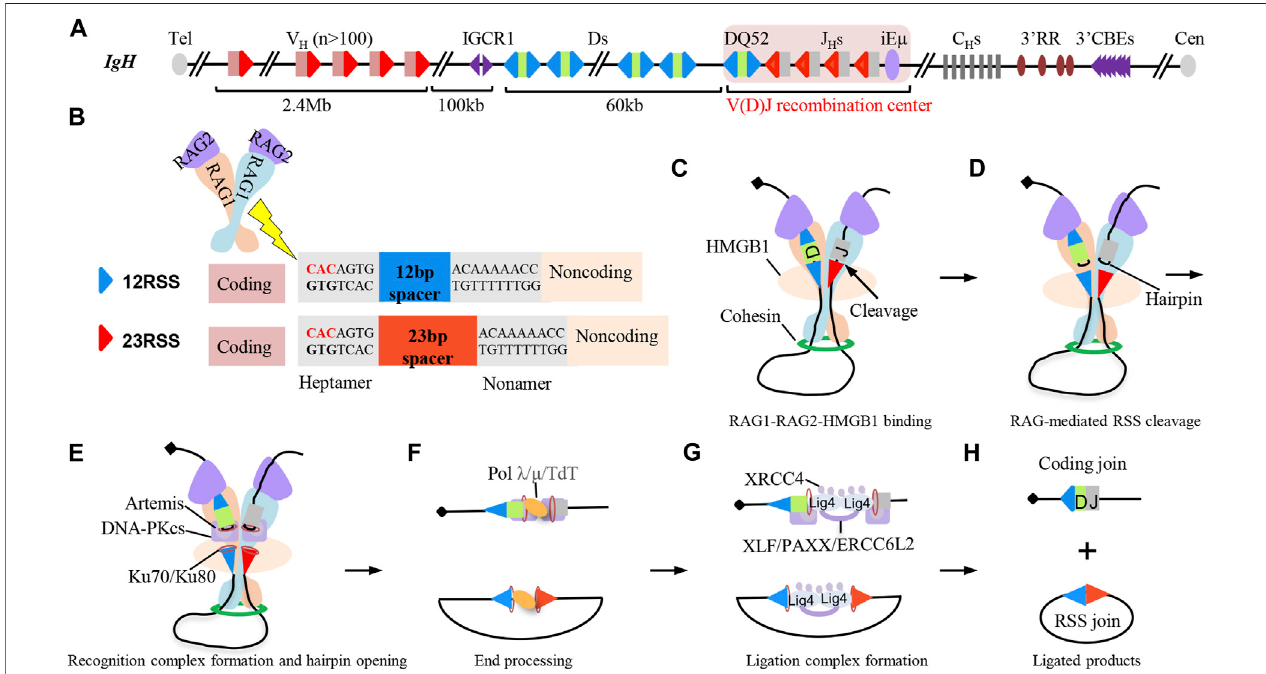
FIGURE 2 | Classical non-homologous end-joining (C-NHEJ) joins RAG-initiated recombination signal sequence (RSS) breaks to complete V(D)J recombination. (A) Schematic structure of the IgH locus in mice. There are over one hundred V H segments, 9 – 12 D segments, and 4 J H segments in mouse IgH locus. Each V H is downstream fl anked by 23RSS. Each D is fl anked by 12RSS on both sides. Each J H is upstream fl anked by 12RSS. (B) Schematic structure of RAG endonuclease, 12RSS (blue triangles), and 23RSS (red triangles). RAG cleaves the heptamer of RSS sequences. (C – H) C-NHEJ-mediated end-joining process during D to J H recombination.RAGandHMGB1bindtoapairofDandJ H segmentsforcleavage,andthesynapsisofDandJ H segmentsispromotedbyloopextrusion-mediatedRAG scanningprocess (C) .RAGcutsthesynapsedRSSsassociatedwiththeDandJ H segmentstogenerateapairofbluntRSSendsandapairofhairpin-associatedcoding ends (D) .Ku70/Ku80complexbindstotheRAG-initiatedDSBsandrecruitsDNA-PKcs-Artemiscomplextoopenthecodingend-associatedhairpins (E) .RAG-initiated breakscanfurtherbeprocessedbyDNApolymerase λ / μ andterminaldeoxynucleotidyltransferase(TdT) (F) .XRCC4andligase4arerecruitedtothebreakstoligatethe processed DNA breaks, and other redundant C-NHEJ factors including XLF, PAXX, and ERCC6L2 are also involved in the ligation step (G) .Final D to J H recombination products include the coding join and RSS join (H)